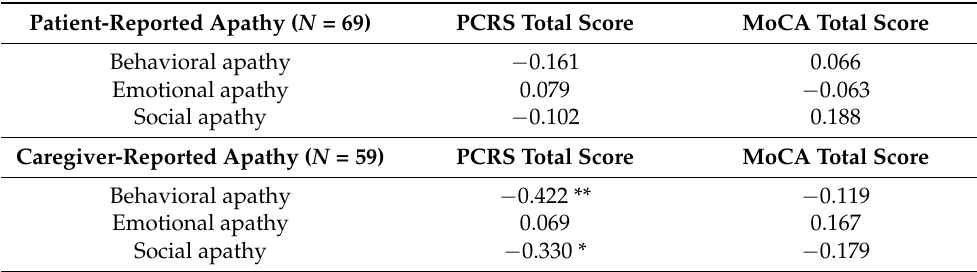
Table 2. Pearson correlations between patient-reported and caregiver-reported behavioral, emotional, and social apathy assessed using the apathy motivation index, everyday functioning assessed using the patient competency rating scale (PSRS), and cognitive functioning assessed using the Montreal cognitive assessment (MoCA).